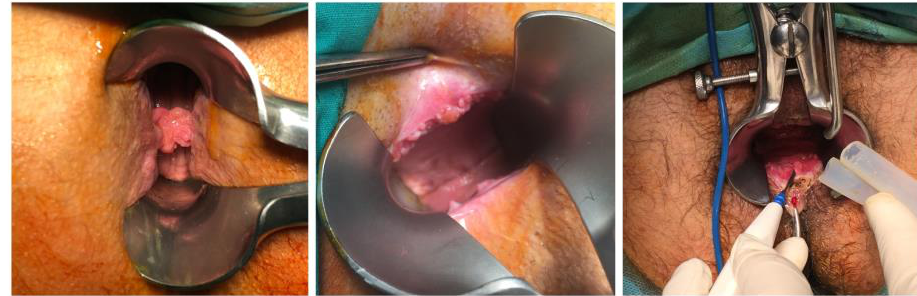
Figure 5. Lesions of CA revealed during proctoscopy using Eisenhammer Rectal Speculum.